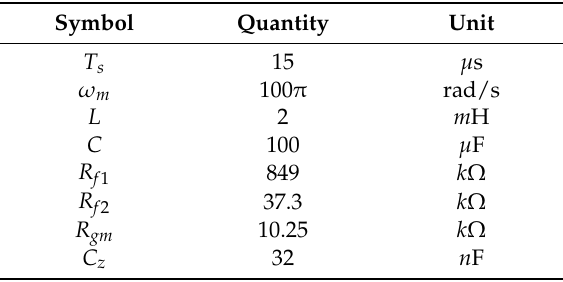
Table 1. Parameters in the OCC Boost PFC converter.